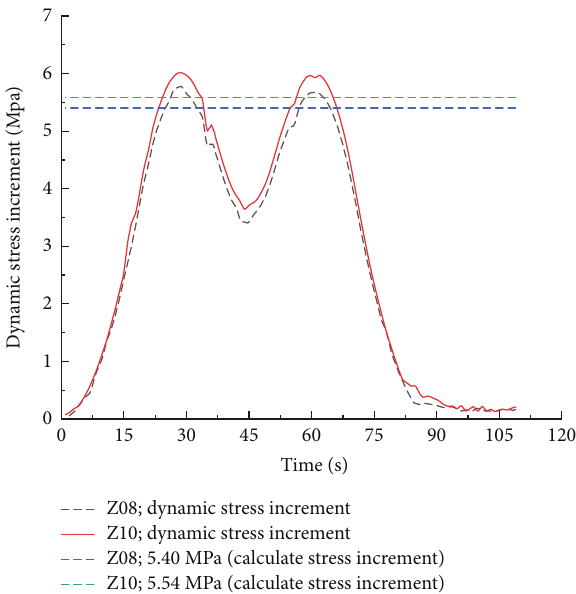
Figure 16: Dynamic stress increment of the first test box